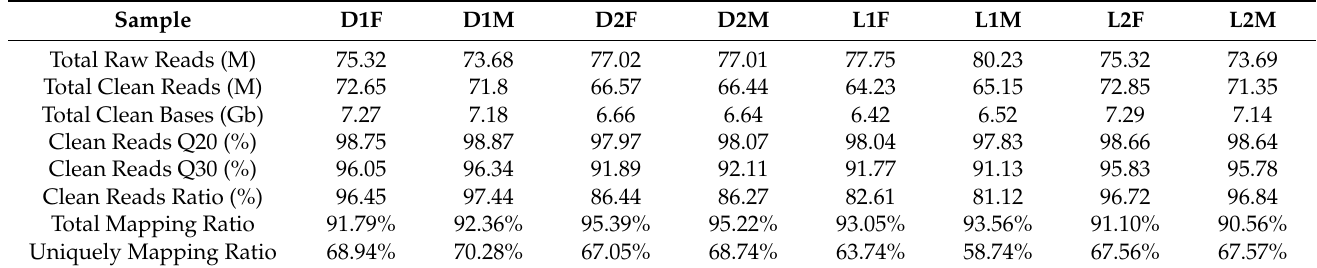
Table 2. Summary of the sequencing data quality and statistics of the